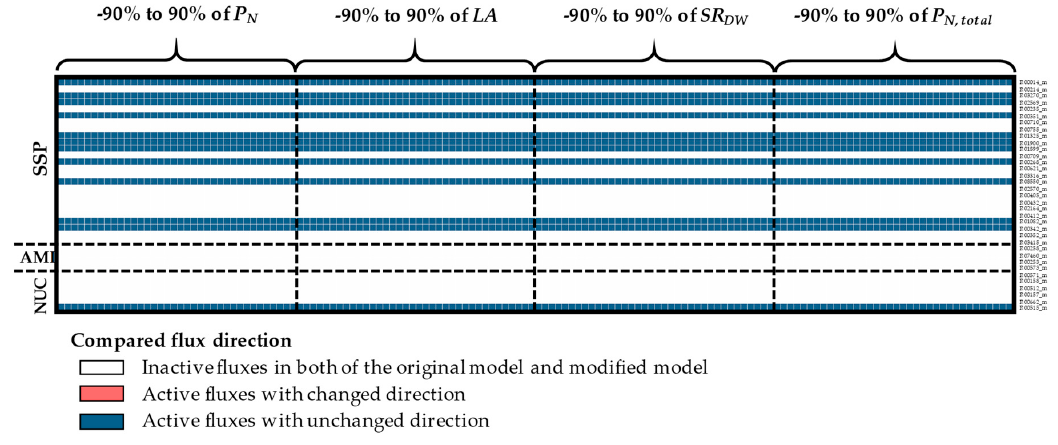
Figure A3. The sensitivity of mitochondrial reaction flux direction to variations in the sucrose uptake rate-related data. Inactive reactions containing zero fluxes are denoted by white-colored grids. Active reactions, non-zero fluxes, with similar flux direction as the original model are denoted by blue grids; while those with dissimilar flux direction (breakpoint) are denoted by red grids. LA ; total leaf area per plant; P N , photosynthetic rate; P N, total , total photosynthetic rate per plant; SR DW , storage root dry weight per plant; AMI, amino acid biosynthesis pathway; NUC, nucleotide biosynthesis pathway; SSP, starch and sucrose biosynthesis pathway.